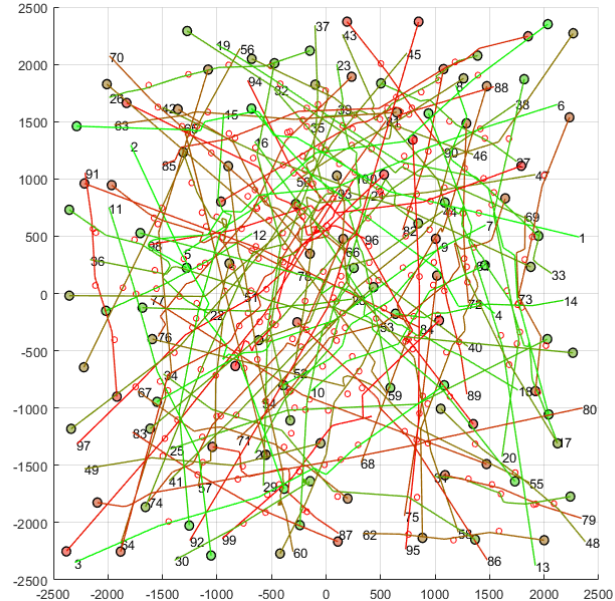
Figure 5. Example of simulated random scenario showing the route followed by 100 UAVs (upper view). Numbers represent initial positions and circle represent current positions and safety areas. Units on axes are meters.